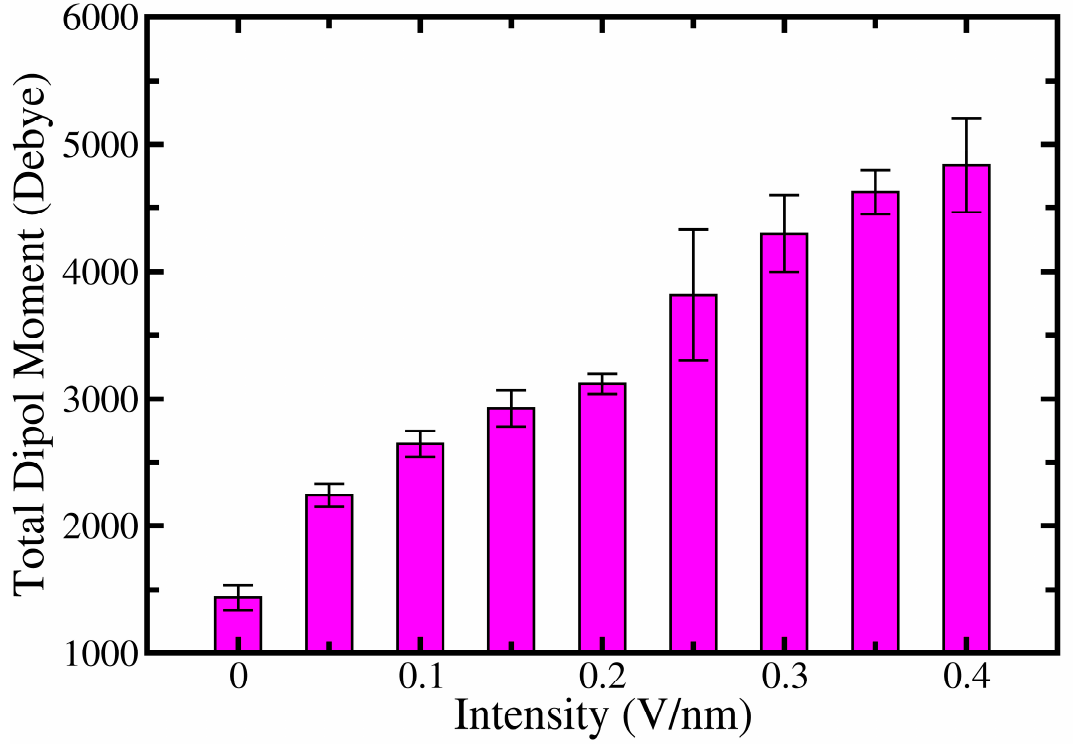
Figure 4. The total dipole moment of fi brillar complex depending on EF